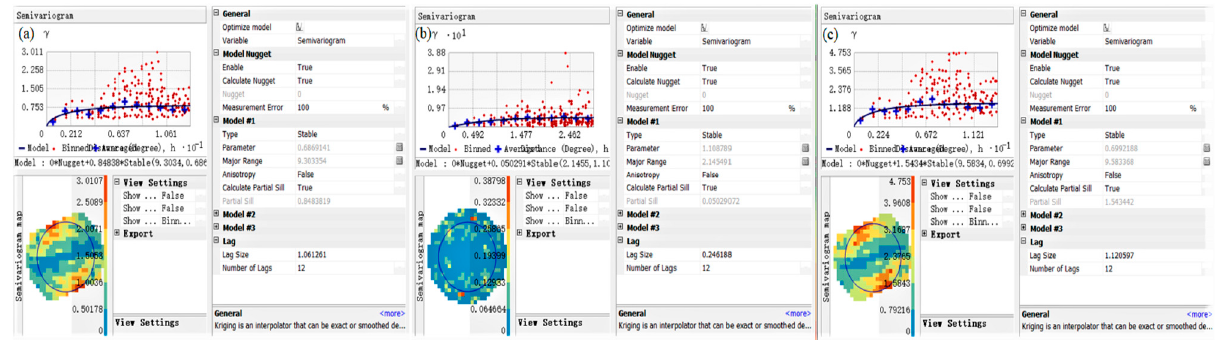
Figure A1. Cold spot and hotspot distribution of the precipitation ( a ) and temperature ( b ) in the study area. Note: The polygons are based on the spatial location of 94 meteorological stations using the Ty son polygon method.